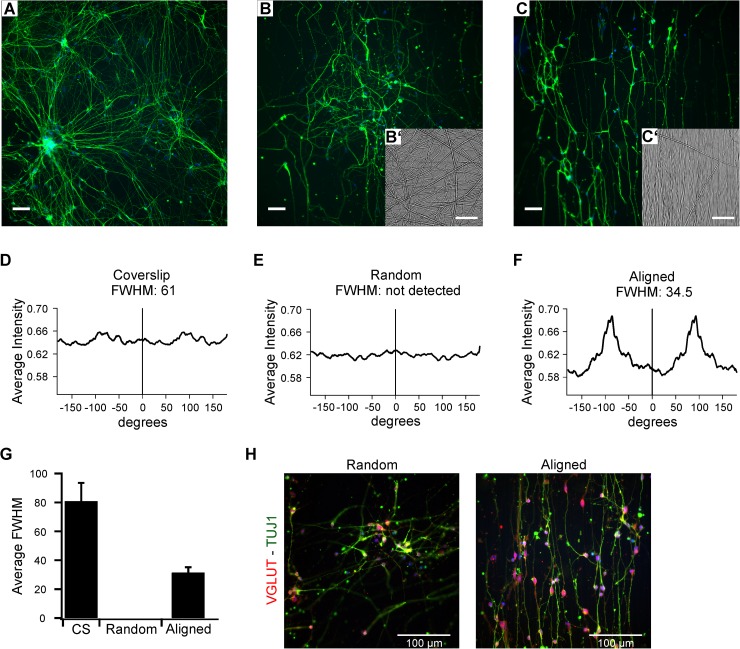
Neurite alignment on nanofiber mats in vitro.(A–C) Representative images of TUJ1 stained terminally differentiated H7 hESC derived neurons (green) on PS coverslips (A) and unaligned (B) and aligned (C) nanofiber mats. Insets in B’ and C’ show light microscopic images of unaligned and aligned nanofiber mats. (D–F) Plot of image intensity as a function of angle with corresponding FWHM values after Fourier transformation of fluorescence images of A, B and C illustrating the extent of alignment. A low FWHM indicates high alignment. (G) Quantification of FWHM values of coverslips (n = 8) and unaligned (n = 7) and aligned (n = 6) fibers terminally differentiated for 2–6 weeks. For random samples, only one out of 7 samples allowed FWHM calculation. (H) Immunohistochemistry for TUJ1 (green) and VGLUT1 (red) shows that neurons maintain a glutamatergic fate on fiber mats. Scale bars represent 100 μm in A, B, C and H and 50 μm in B’ and C’.